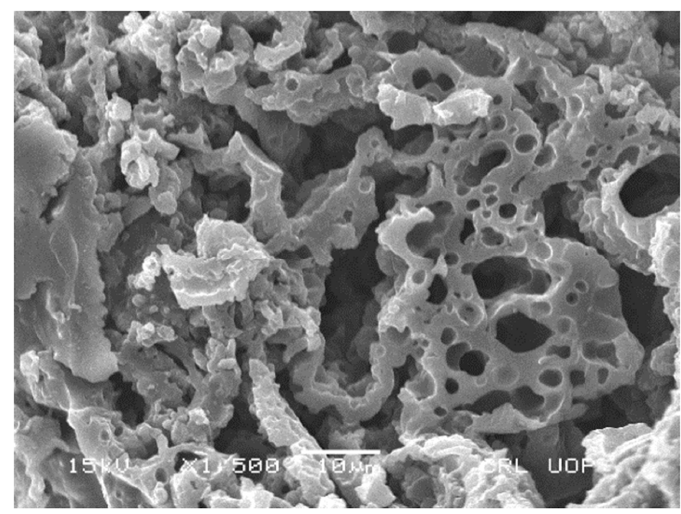
Figure 15. Scanning electron micrograph of PANI salt.